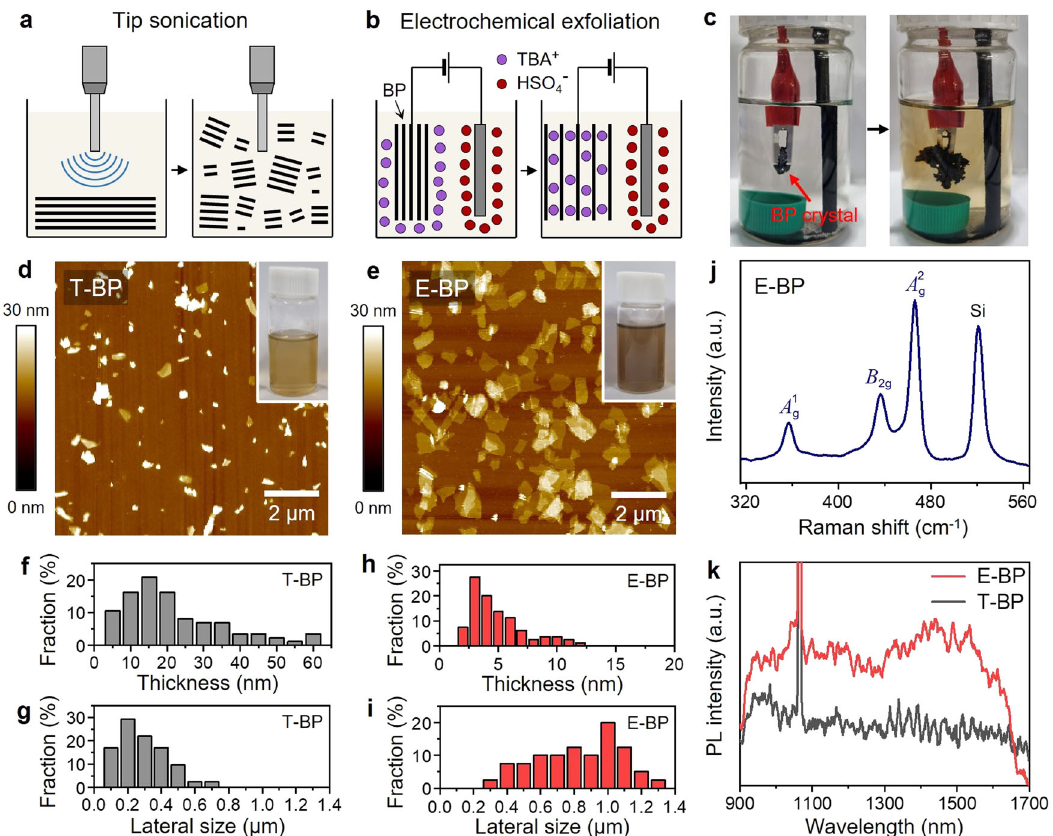
Fig. 1 Side-by-side comparison between tip-sonicated and electrochemically exfoliated BP nanosheets. a , b Schematic illustration of the two exfoliation methods. c Photographs of the BP crystal before and after electrochemically driven molecular intercalation. d , e AFM images of the tip-sonicated BP (T-BP) and electrochemically exfoliated BP (E-BP) nanosheets. Photographs of the dispersions are also provided as insets. f Nanosheet thickness and g lateral size histogram of T-BP. h Nanosheet thickness and i lateral size histogram of E-BP. j Raman spectrum of E-BP. k Photoluminescence spectra of T-BP and